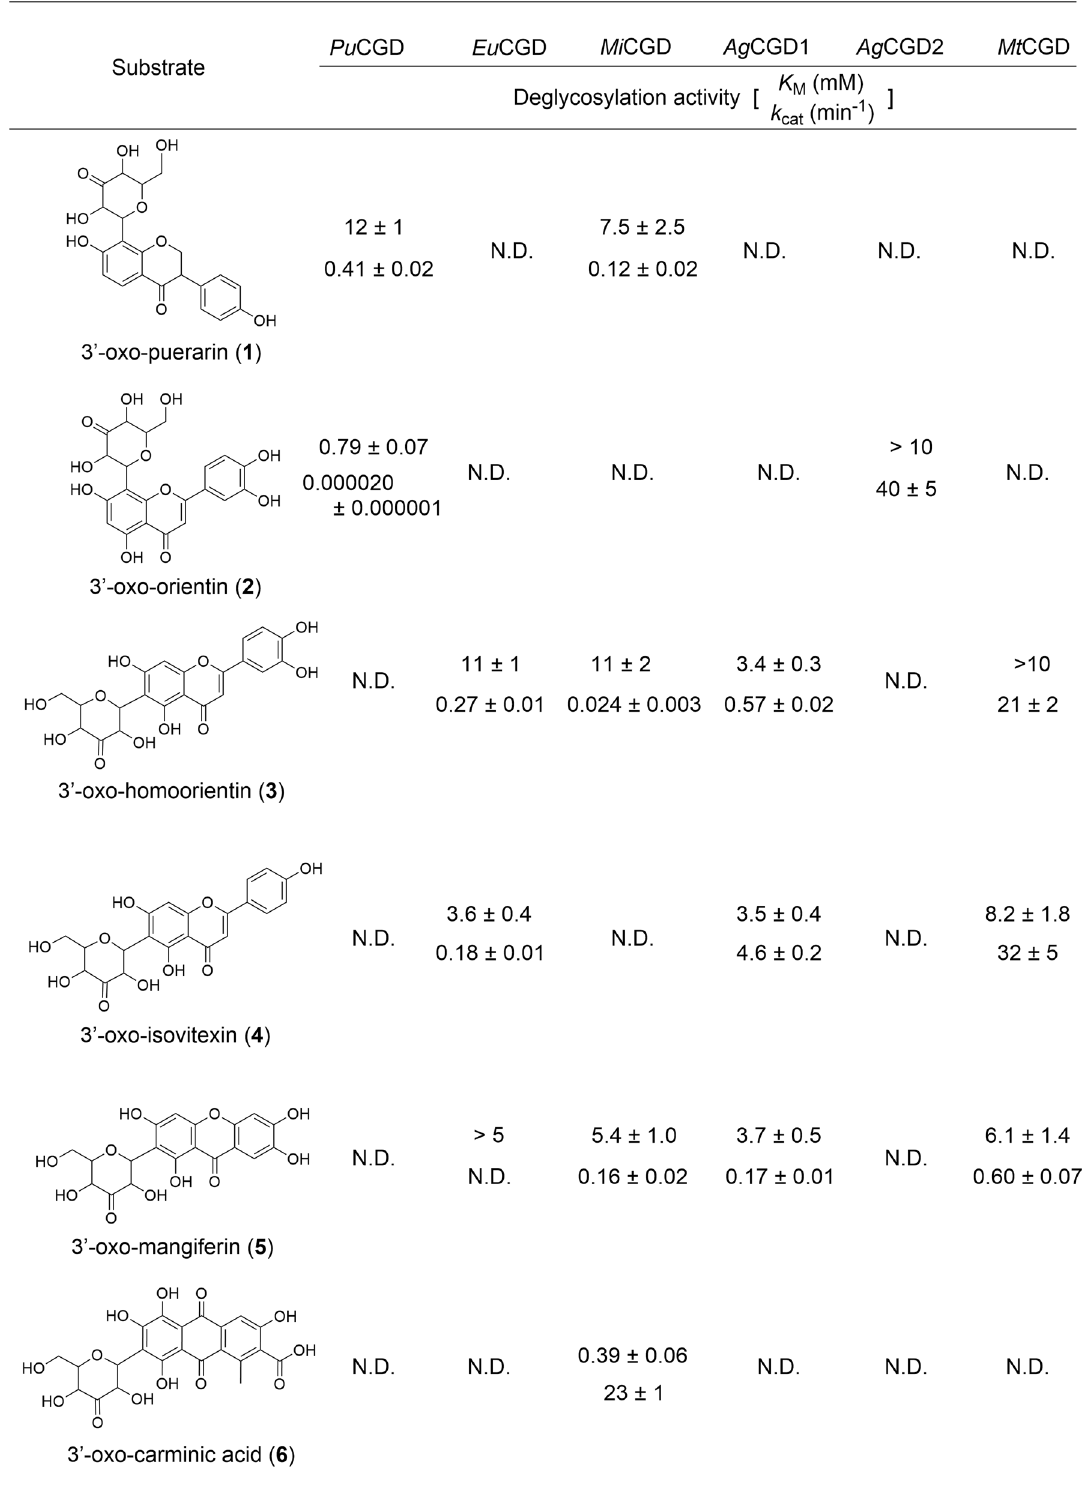
Fig. 2 Substrate speci fi cities of C -deglycosylation reactions. The kinetic parameters of each C -deglycosylation enzyme towards C -glycosides were shown. In each set of numbers, the upper and lower numbers represent K M (mM) and k cat (min − 1 ), respectively. N.D.: not